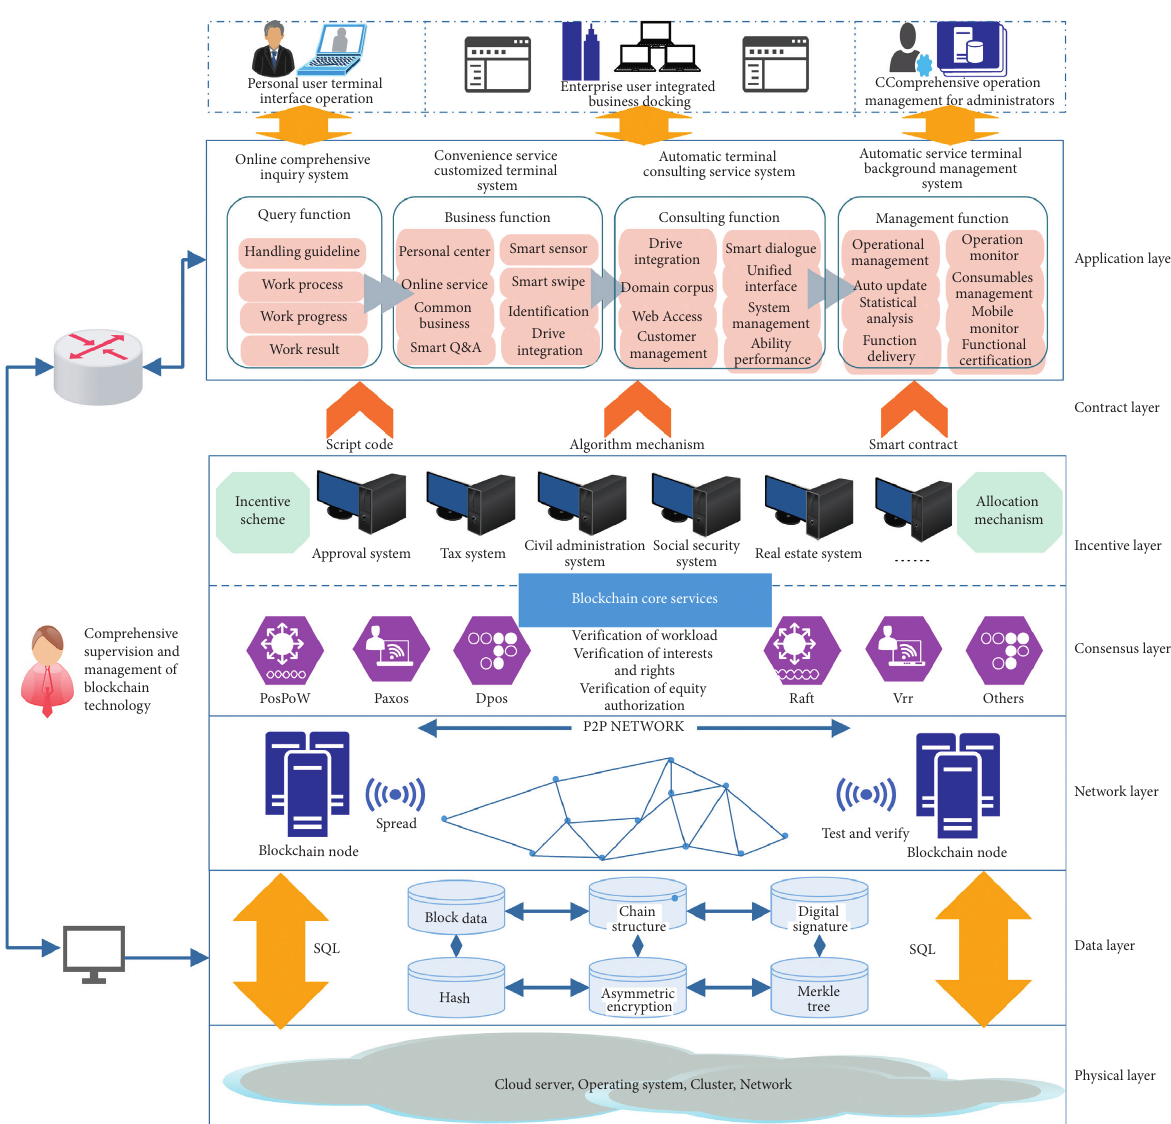
Figure 3: Modified smart government platform architecture with blockchain